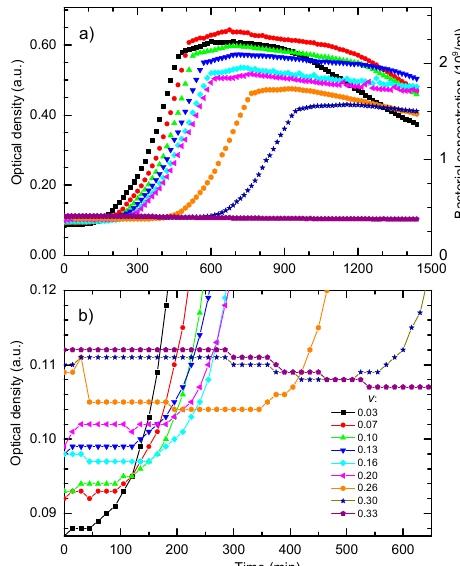
Figure 2. ( a ) Growth data of E. coli treated with di ff erent concentrations of silver nanoparticles, i.e., di ff erent colloid volume shares v . The OD in absorbance units is given on the left axis and the corresponding bacterial concentrations in CFU / mL are given on the right axes. ( b ) The first 650 min of the experimental OD data given in Figure